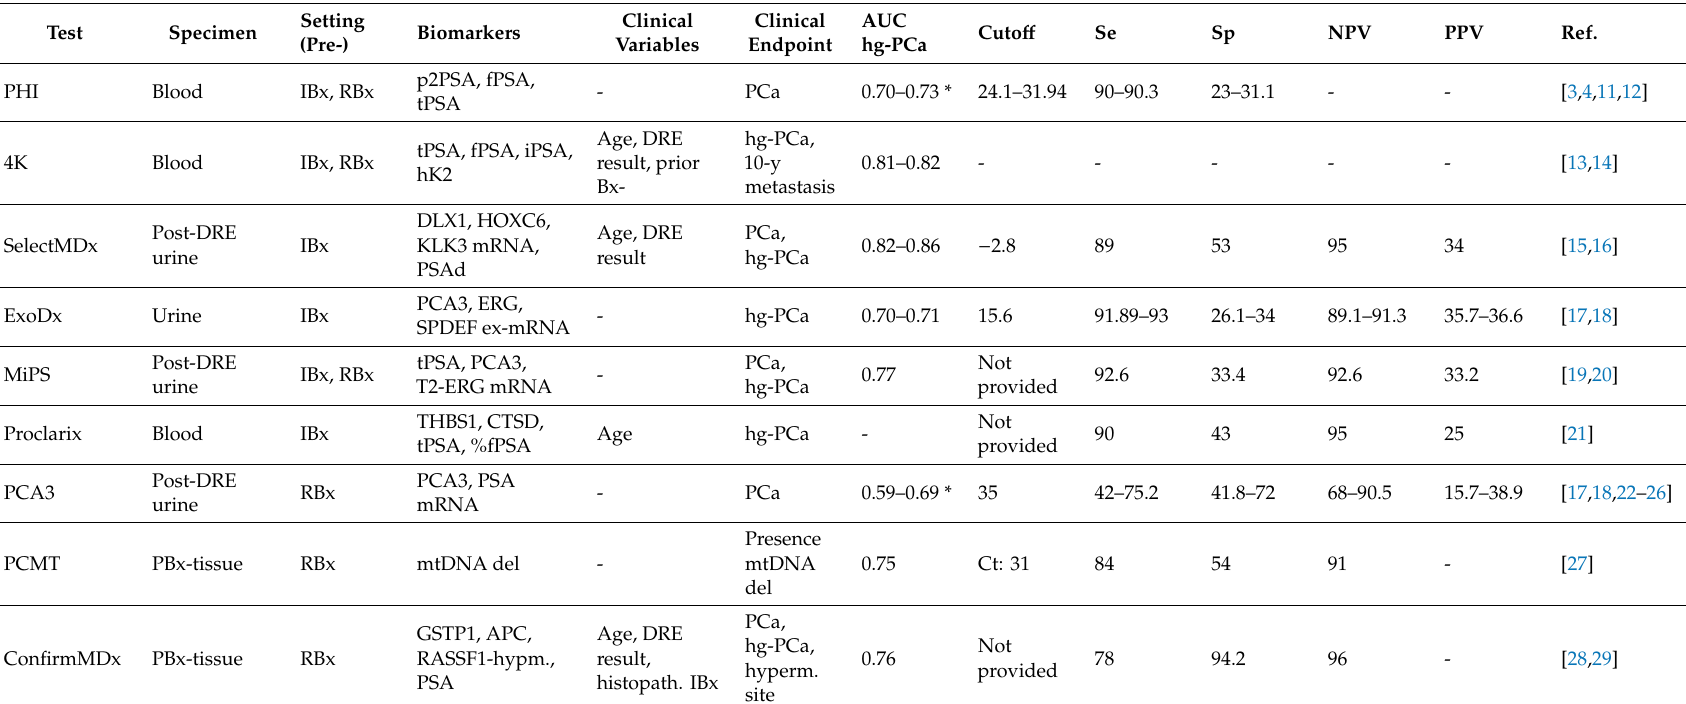
Table 1. Commercialized biomarker tests for initial and repeated biopsy